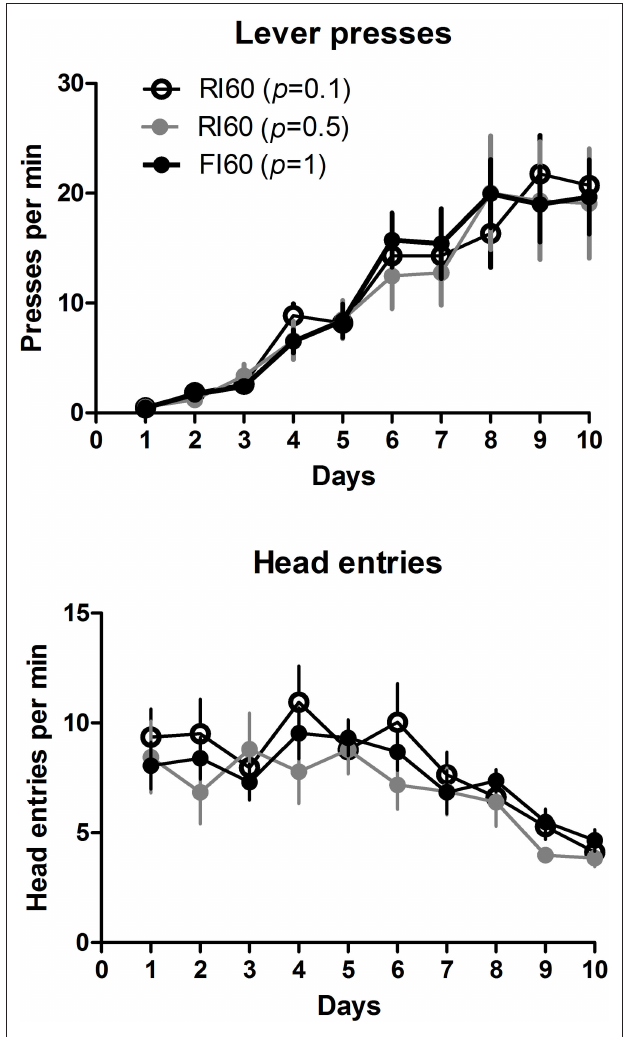
FIgure 2 | rates of lever pressing and head entries into the food magazine during the first 10 days of lever press acquisition. The schedules used